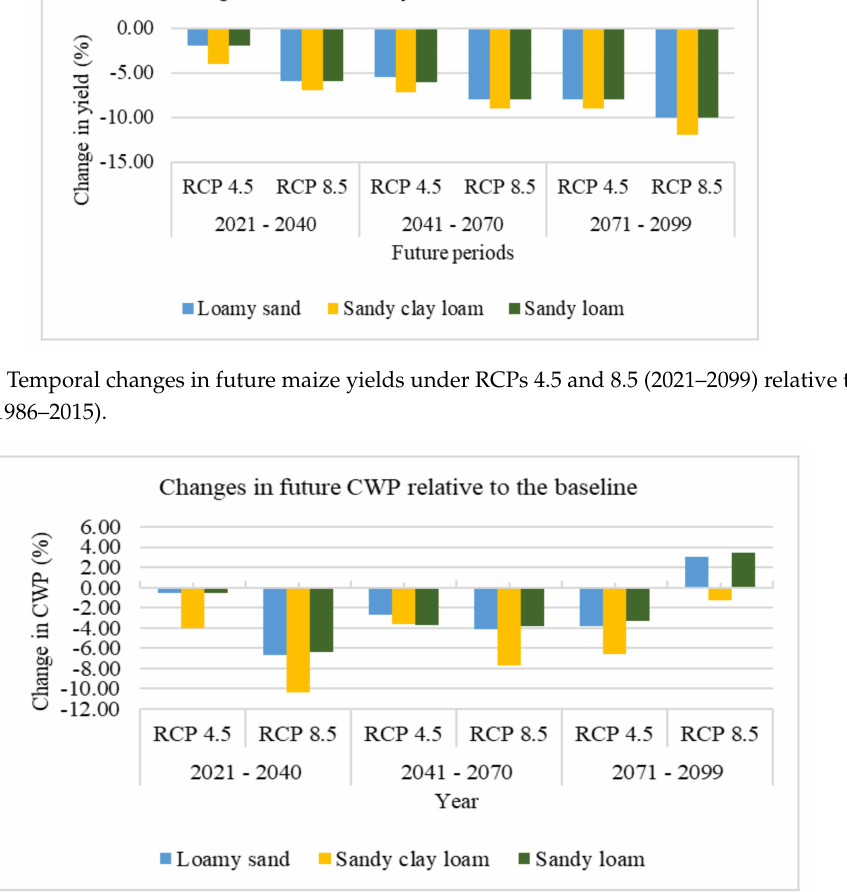
Figure 12. Temporal changes in future maize CWP under RCPs 4.5 and 8.5 (2021–2099) relative to the baseline